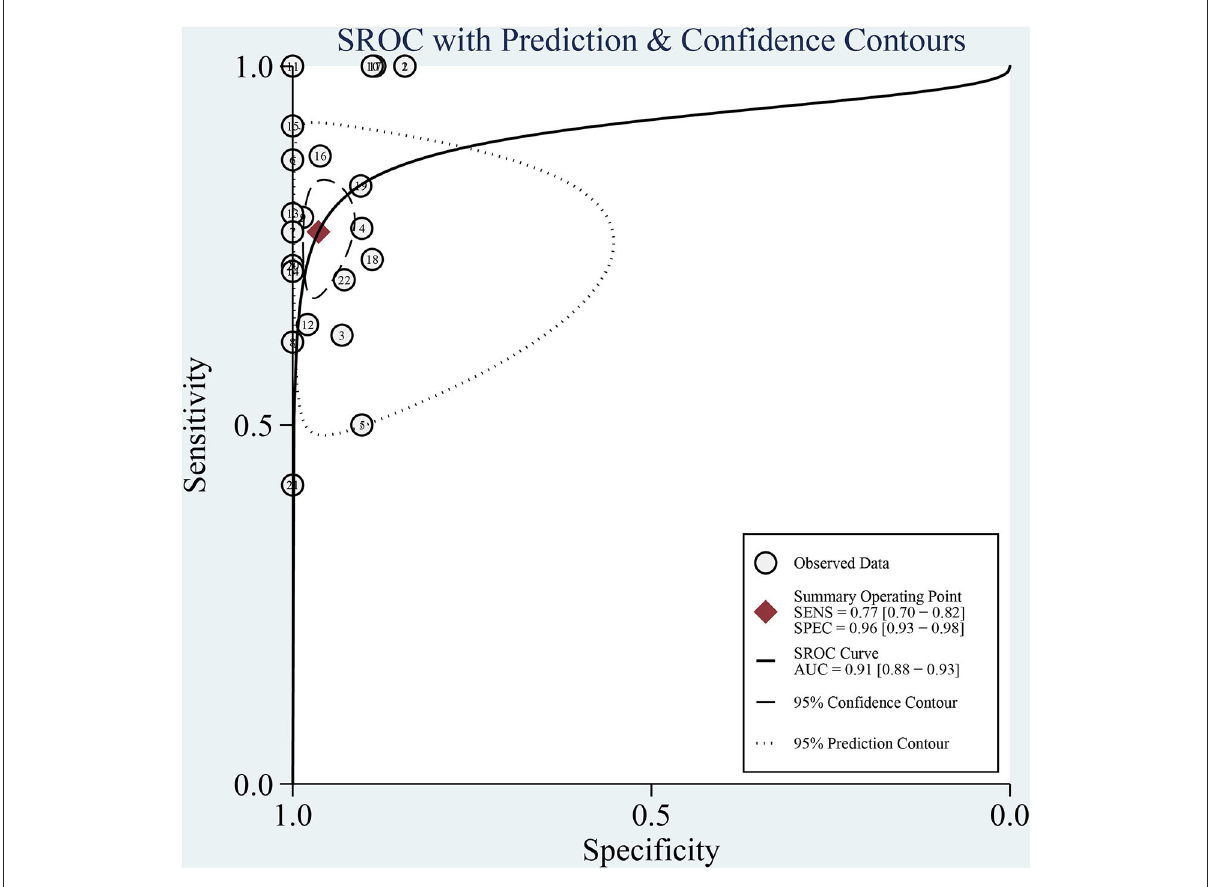
FIGURE5 The SROC curve of mNGS diagnosis of CNS